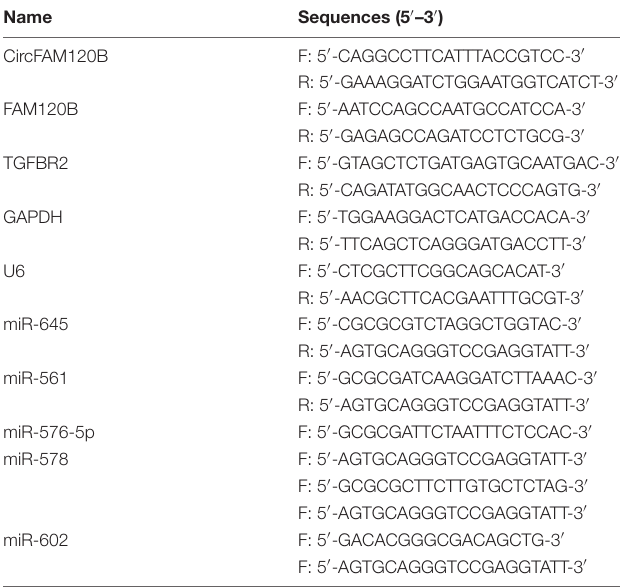
TABLE 1 | The primer sequences for quantitative real-time polymerase chain reaction (qRT-PCR).